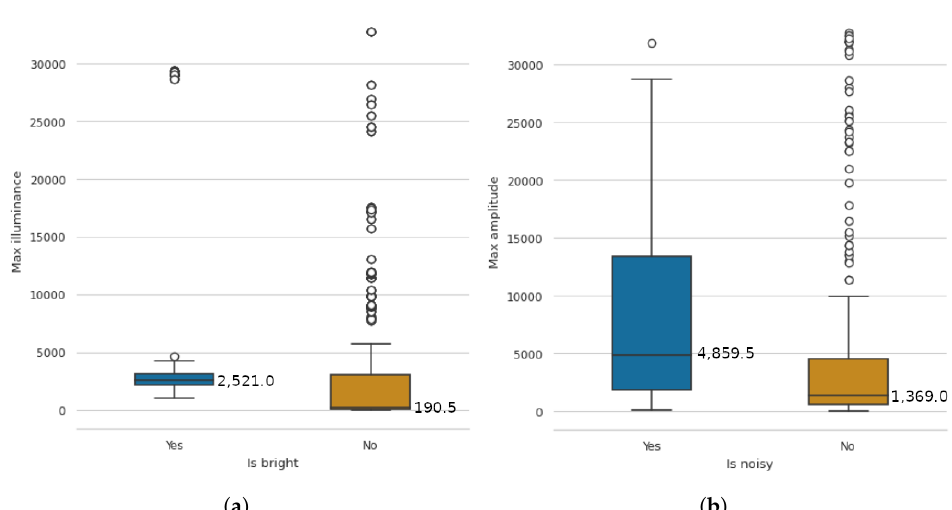
Figure 7. This figure shows the sensor data related to the two PLE factors: ( a ) lighting: The data show that, on average, the lighting conditions measured by the sensors match the self-reported PLE conditions. The median of the not very bright environment is 190.5 lx, which corresponds to normal room lighting. The median of the very bright environment is 2521.0 lx, which corresponds to very bright room lighting; and ( b ) audible noise: The data show that, on average, the noise conditions measured by the sensors are consistent with the self-reported PLE conditions. The median amplitude of a not very noisy environment is 1369.0 (62.7 dB), which corresponds to a regular noisy background. The median amplitude of a very noisy environment is 4859.5 (73.7 dB), which corresponds to a very noisy